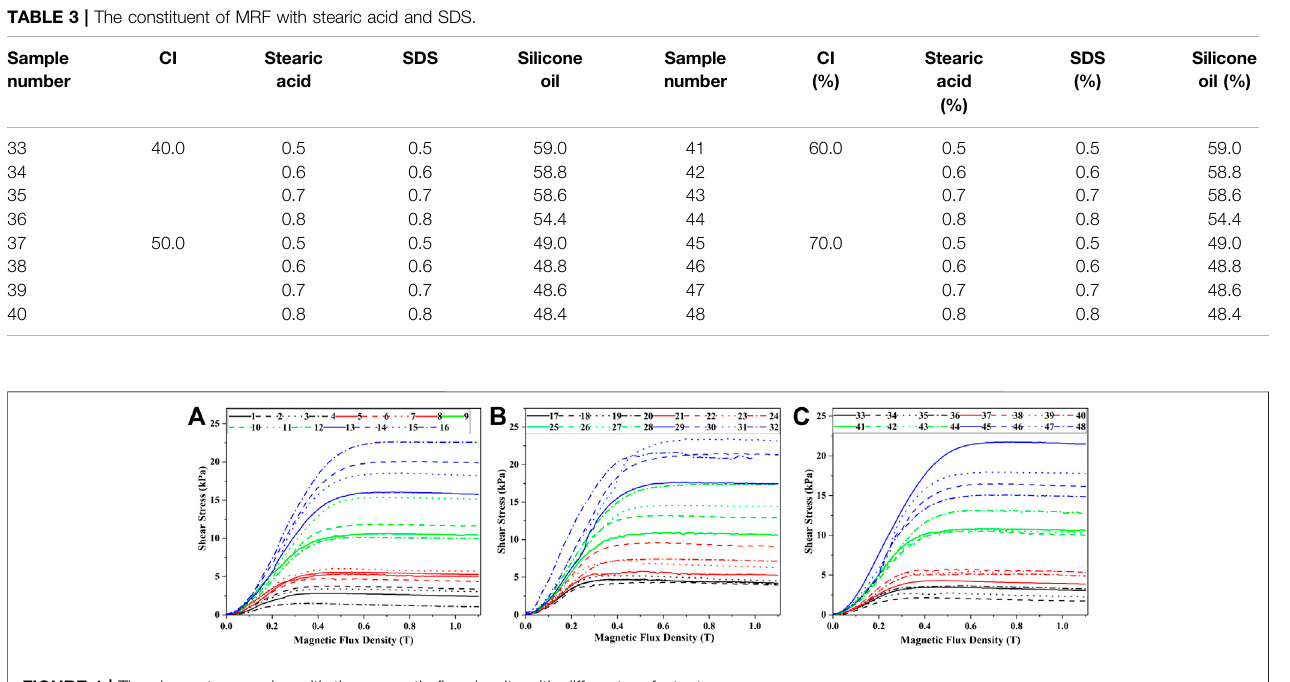
FIGURE 1 | The shear stress varies with the magnetic fl ux density with different